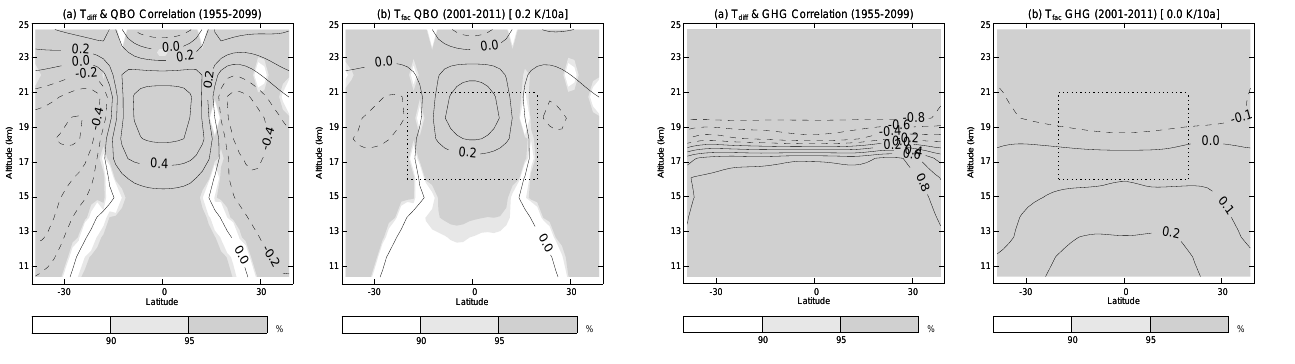
Figure 6. Same as Fig. 3 but for the impact of anthropogenic forc- ings (GHGs) by comparing the Natural and RCP85 experiments; contour interval is (a) 0.2 and (b) 0.1Kdecade − 1 .